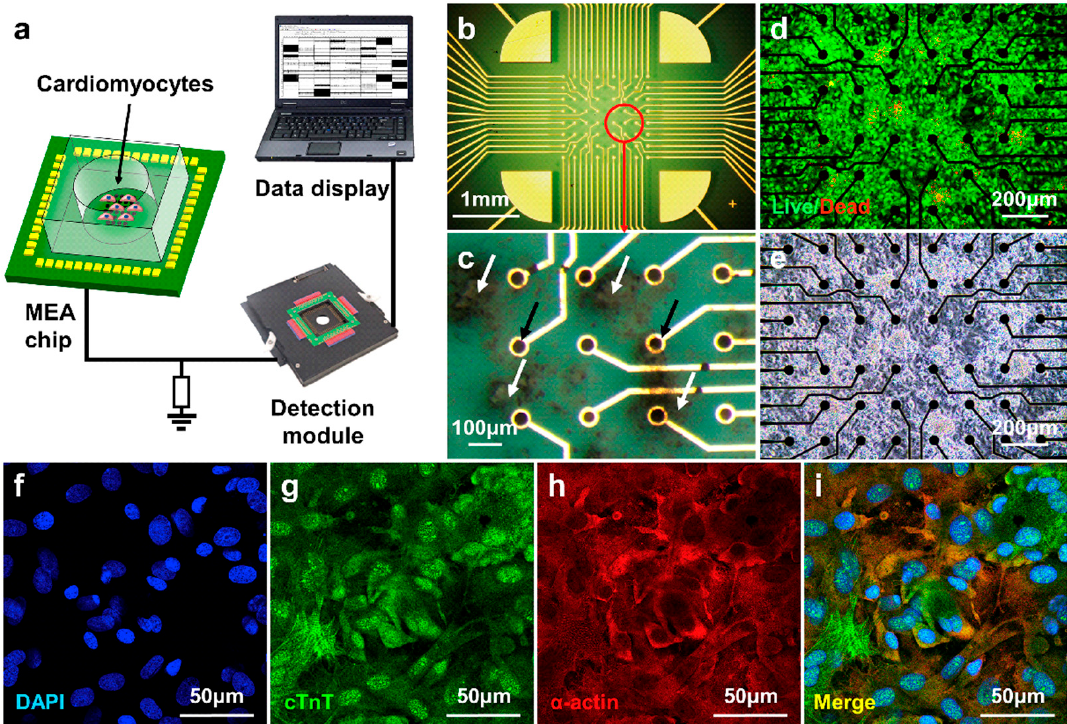
Figure 7. The cell culture results of cardiomyocytes on the MEA sensor. ( a ) Schematic diagram of the taste sensor system based on MEA sensor; ( b – e ) staining and optical micrographs of cardiomyocytes on MEA sensor; ( f – i ) immunofluorescence staining results for the nuclei (DAPI, blue), cardiac troponin T (cTnT, green), and α -actinin (red) in cardiomyocytes and the merged image. Reproduced from [108] with permission from Elsevier.